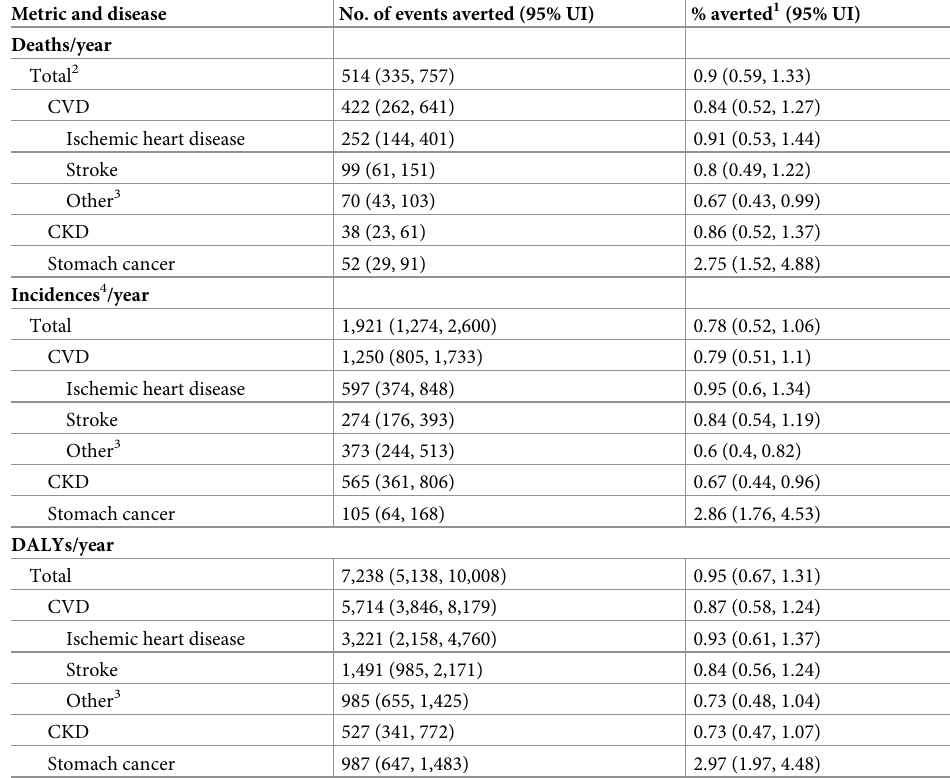
Table 2. Estimated intervention effects on CVD, CKD, and stomach cancer in the adult Australian population by full compliance to the Australian government’s 2020 sodium reformulation program. Metric and